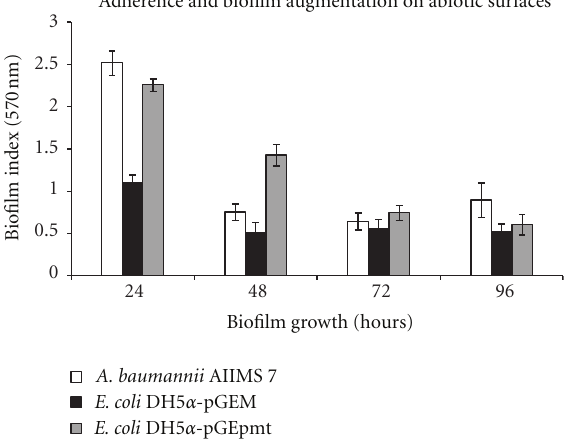
Figure 5: Quantitative analysis of adherence and biofilm formation on abiotic surface (polystyrene microtitre). (Absorbance values normalized with blank medium, P < 0 . 05.)